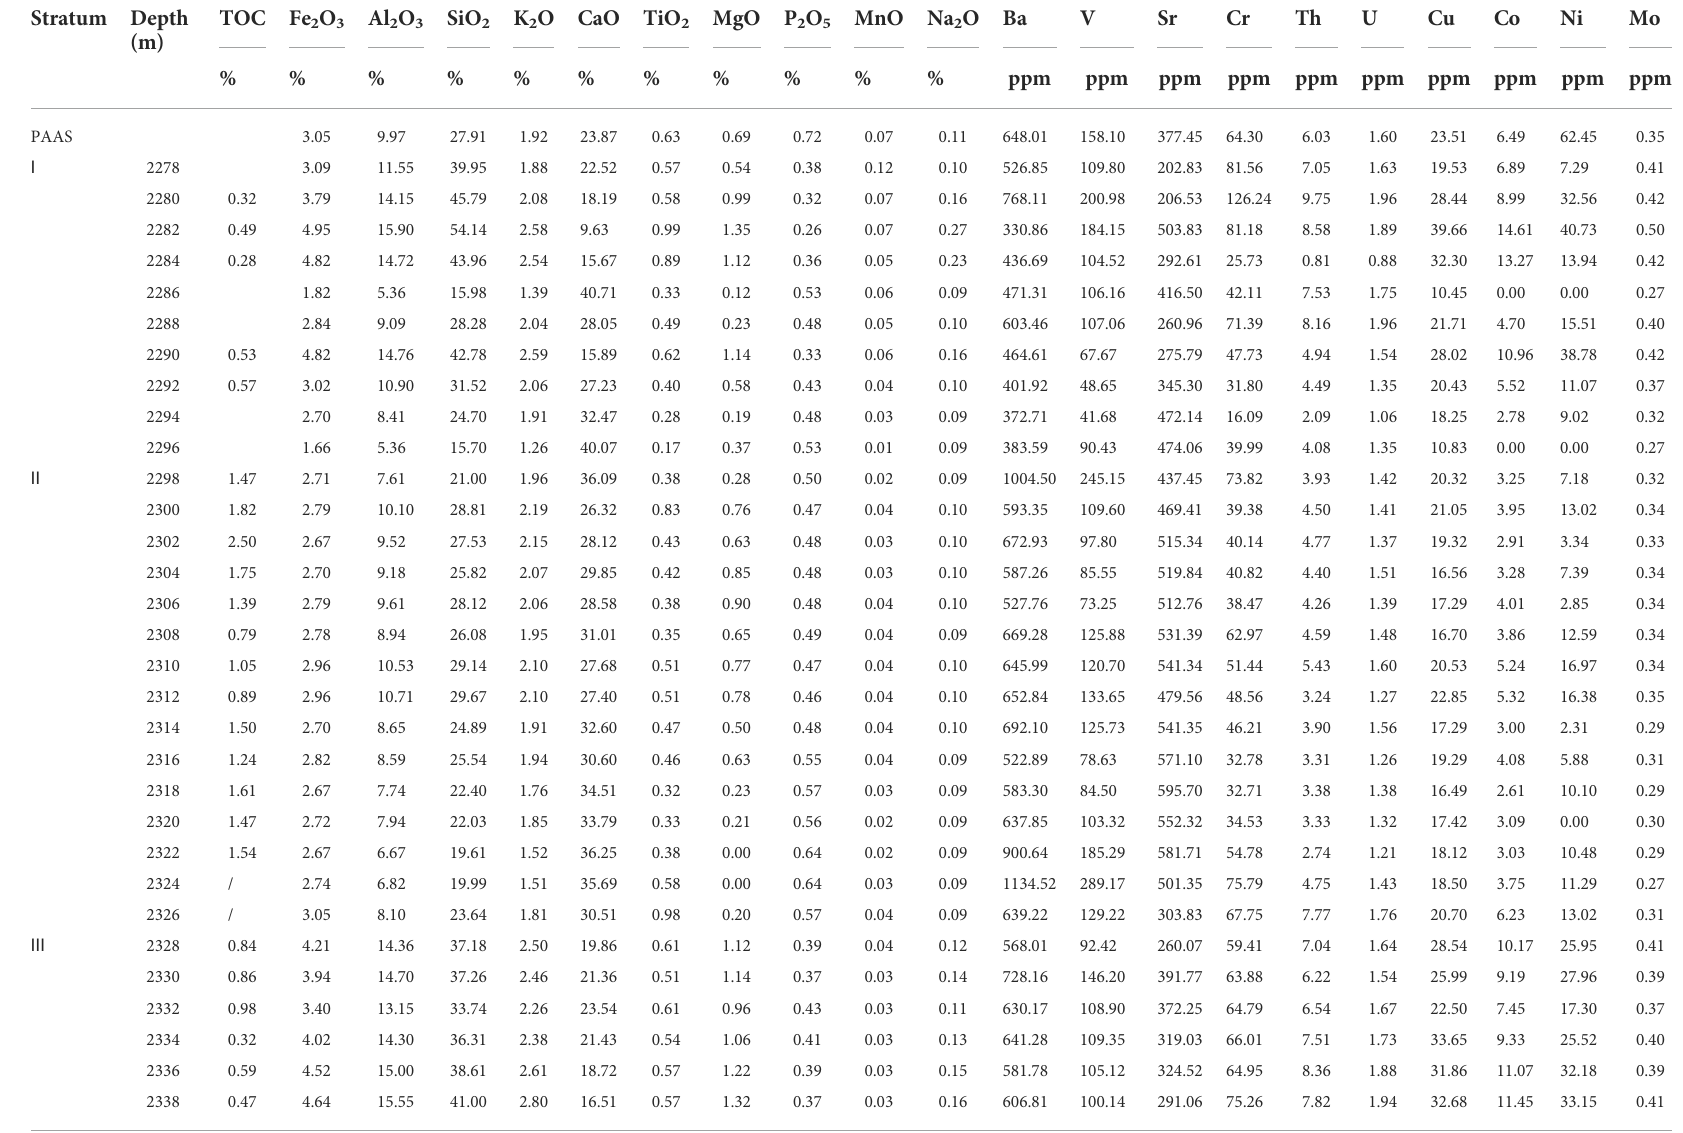
TABLE 1 Measured values of TOC and major elements in Da ’ anzhai shale of well C [PAAS data from Taylor and Mclennan (1985)]. Stratum Depth